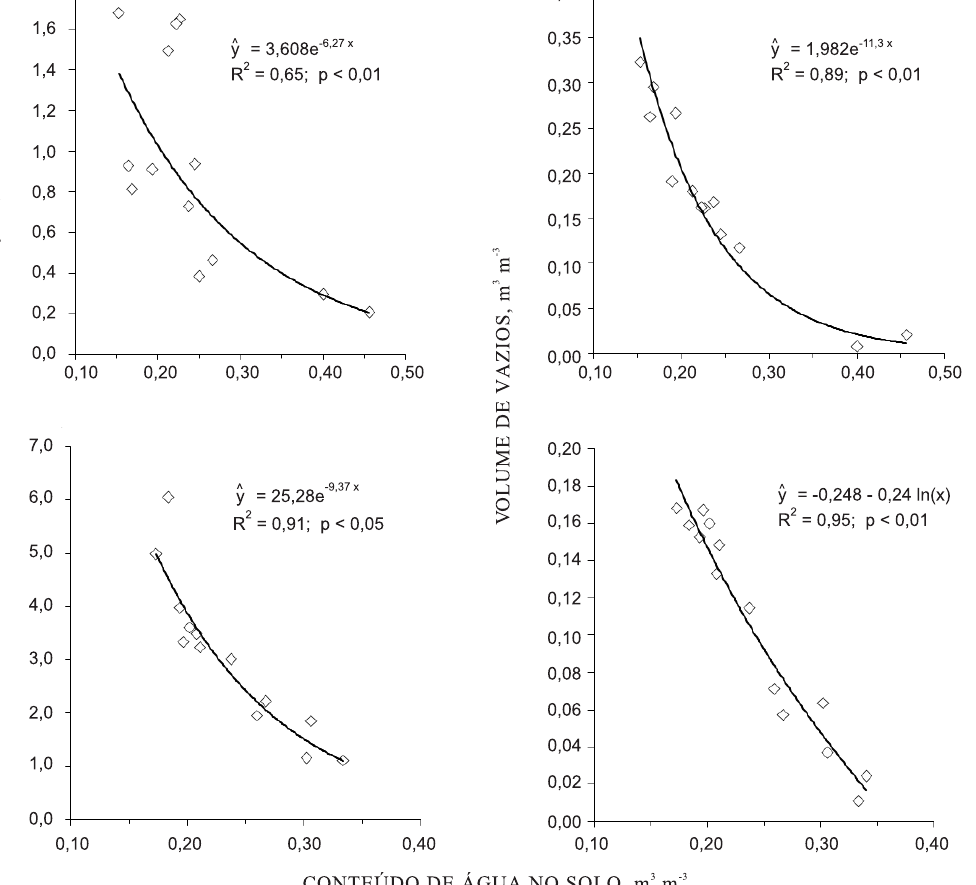
Figura 1. Regressão entre o conteúdo de água volumétrico e a resistência do solo à penetração (a) e volume de vazios (b) de um Latossolo Vermelho para a profundidade de 10–20 cm, para os tratamentos T1 (solo preparado e sem tráfego de máquinas) e T6 (solo preparado e submetido a oito passadas de um trator de 6